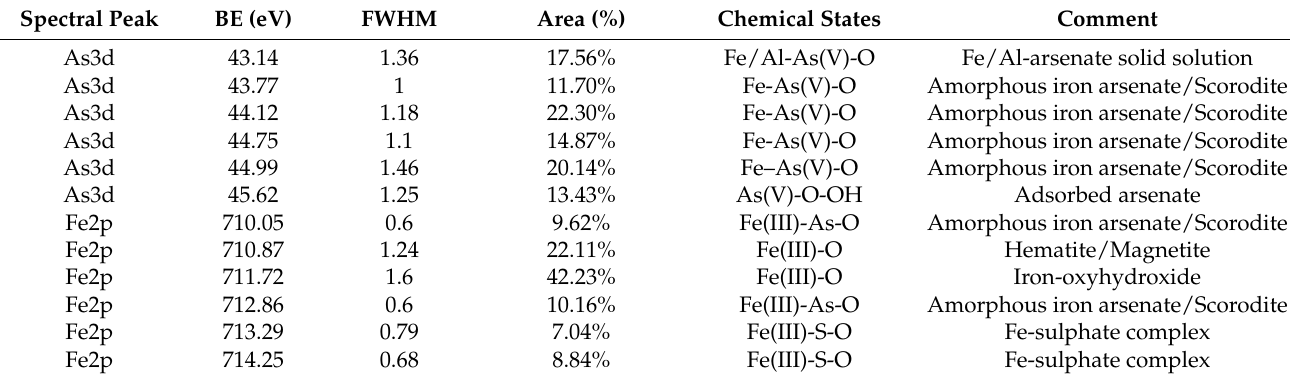
Table 4. XPS data and chemical states of the As-bearing precipitate obtained at 25 ◦